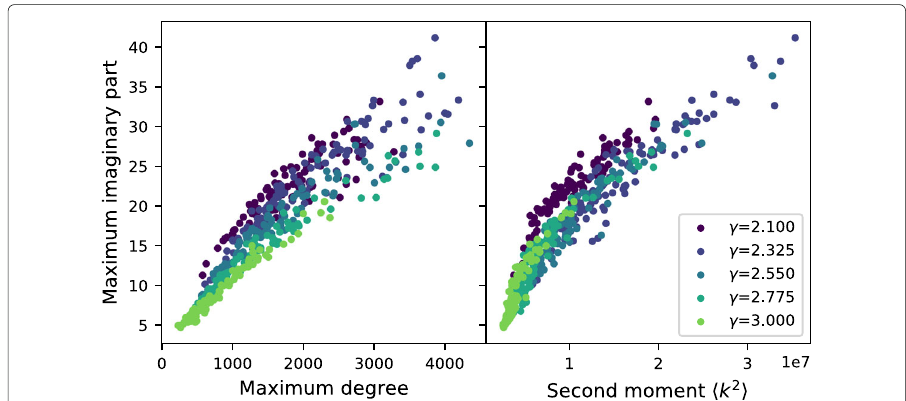
Fig. 4 Spread along the imaginary axis of non-backtracking eigenvalues. We show the imaginary part of non-backtracking eigenvalues as a function of heterogeneity of degree distribution in the configuration model. Given a value of γ , we generated a random degree sequence that follows p k ∼ k − γ and generated a graph with said degree sequence using the configuration model. All graphs have n = 5 × 10 4 nodes and average degree 12; 100 graphs generated for each value of